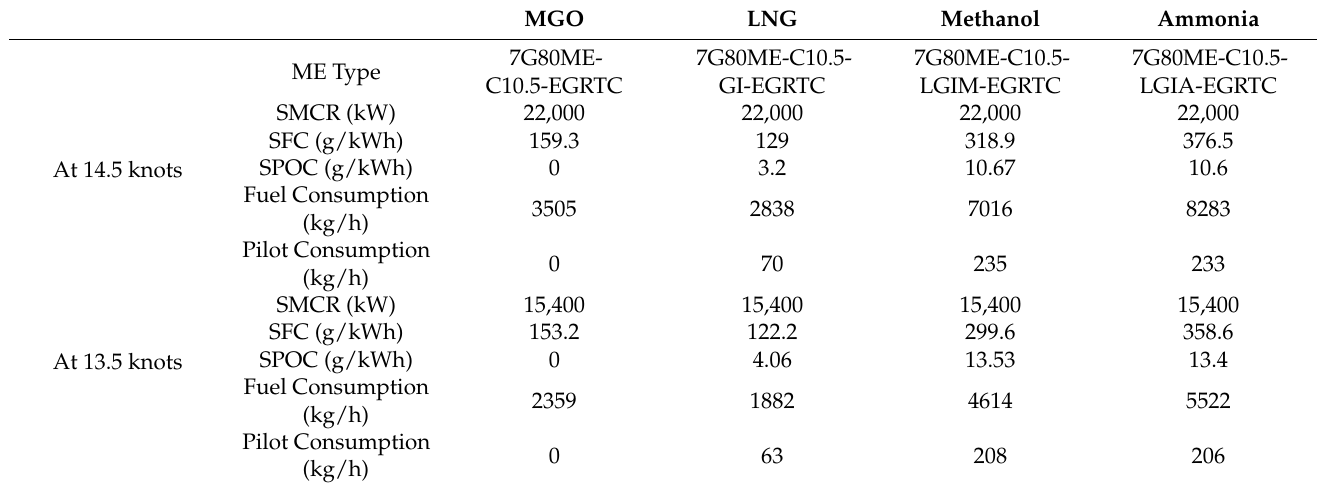
Table 4. The ME’s fuel consumptions at the SMCR point.